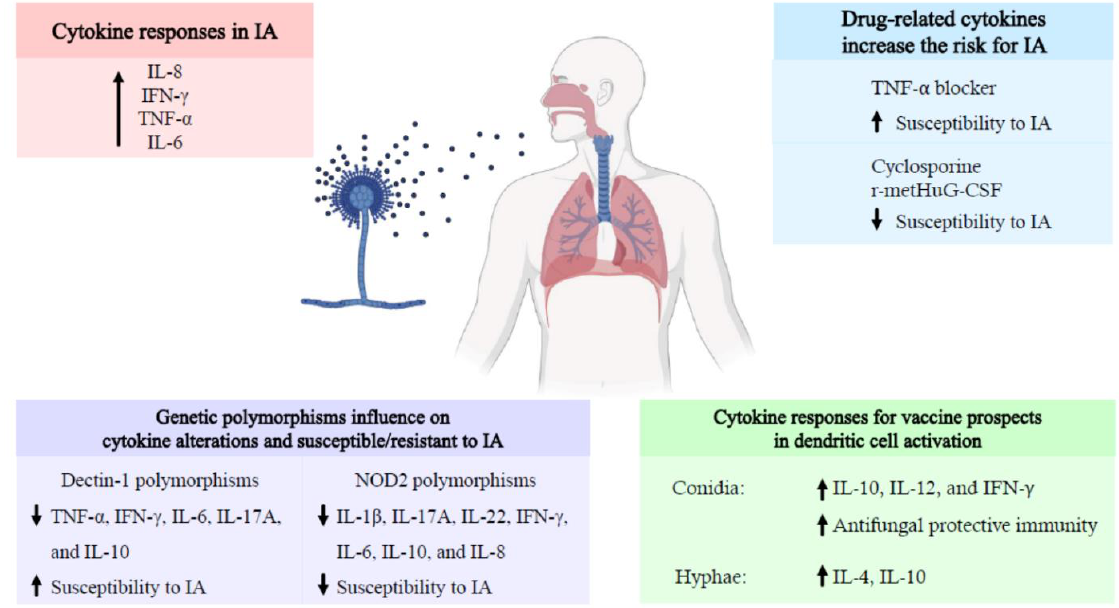
Figure 1. Schematic representation of the cytokine responses associated with invasive aspergillosis in hematopoietic stem cell transplantation. Cytokine responses related to invasive aspergillosis associated with an increase the risk of the disease. Both drugs and genetic polymorphism influence the cytokine expression profile during hematopoietic stem cell transplantation. In addition, different activation patterns of Aspergillus morphotypes lead to different cytokine expression profiles. Abbreviations: IA, invasive aspergillosis; IFN, interferon; IL, interleukin; NOD2, nucleotide oligomerization domain 2; r-metHuG-CSF, recombinant human granulocyte colony stimulating factor; TNF, tumor necrosis factor. The black arrows indicate the increase or decrease in cytokines and